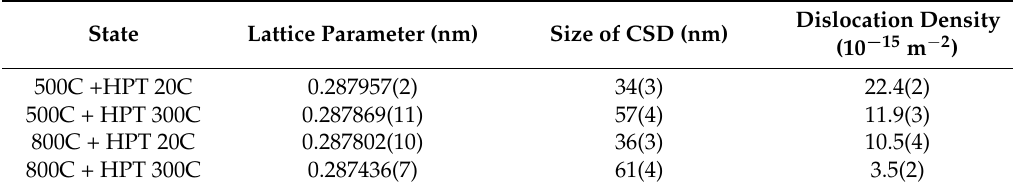
Table 2. Microstructural parameters from X-ray diffraction.